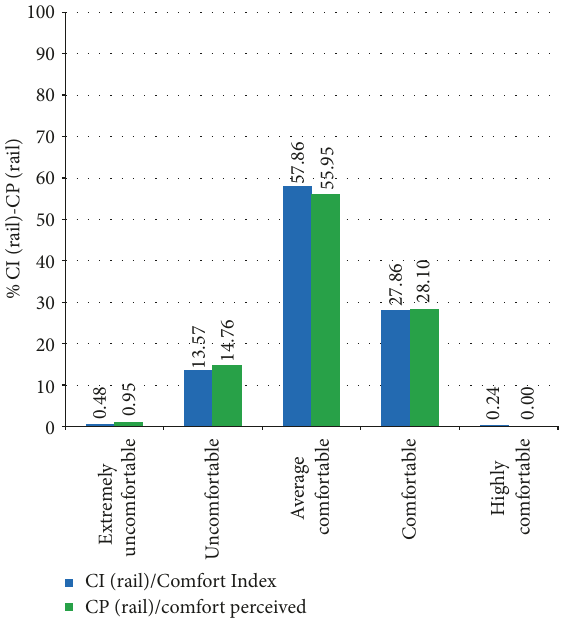
Figure 15: Comparison CI and CP-FCL M2.200 BREDA.